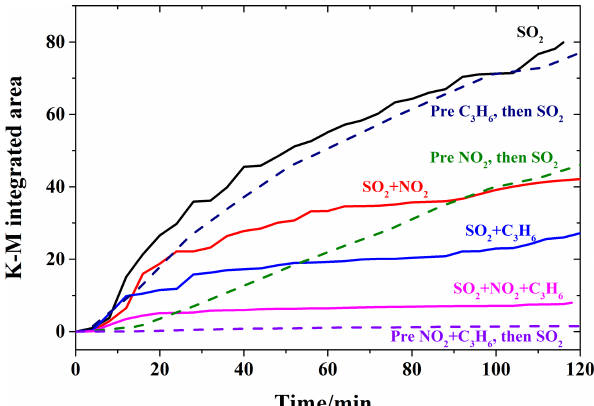
Figure 5. Integrated absorbance of the sulfate band (1168cm − 1 ) for the illuminated reactions with UV–Vis light of 200ppmSO 2 (black, solid), 200ppmSO 2 on a 200ppmC 3 H 6 -presaturated surface (blue, dashed), 200ppmSO 2 + 200ppmNO 2 (red, solid), 200ppmSO 2 on a 200ppmNO 2 -presaturated surface (green, dashed), 200ppmSO 2 + 200ppmC 3 H 6 (blue, solid), 200ppmSO 2 + 200ppmNO 2 + 200ppmC 3 H 6 (pink, solid), and 200ppmSO 2 on a 200ppmNO 2 + 200ppmC 3 H 6 -presaturated surface (purple,